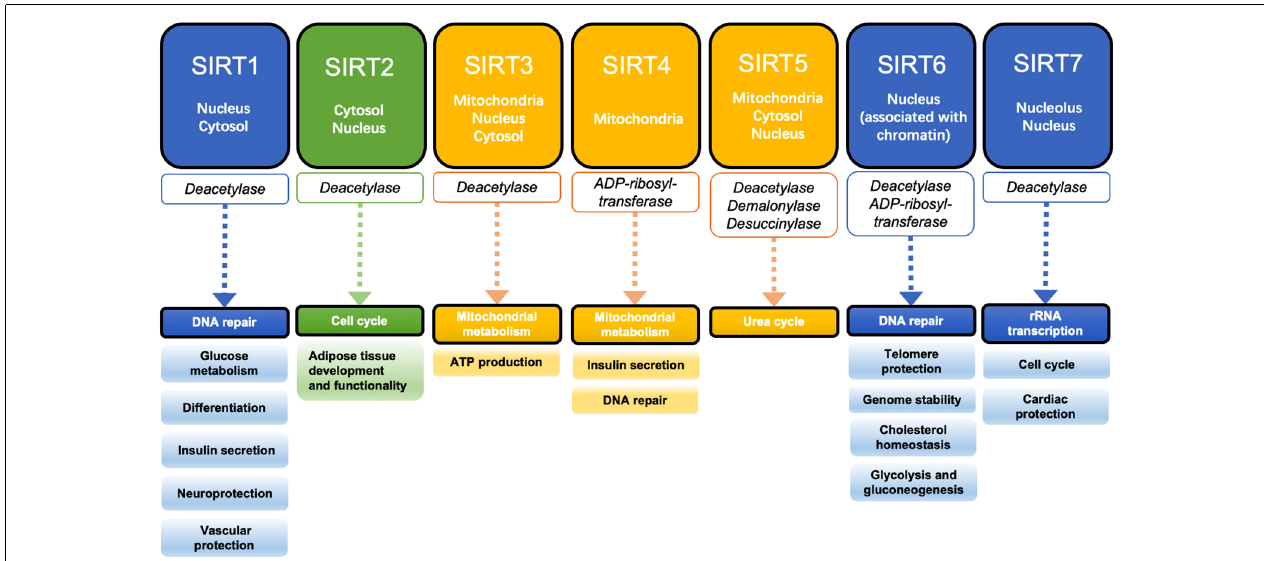
FIGURE 2 | Localization, enzyme activity, and function of the sirtuin family. SIRT1, SIRT6, and SIRT7 are mainly located in the nucleus and regulate DNA repair and gene transcription. SIRT2 is mainly located in the cytosol and plays an important role in the regulation of the cell cycle. SIRT3, SIRT4, and SIRT5 are known as mitochondrial sirtuins and are involved in the regulation of mitochondrial functions.